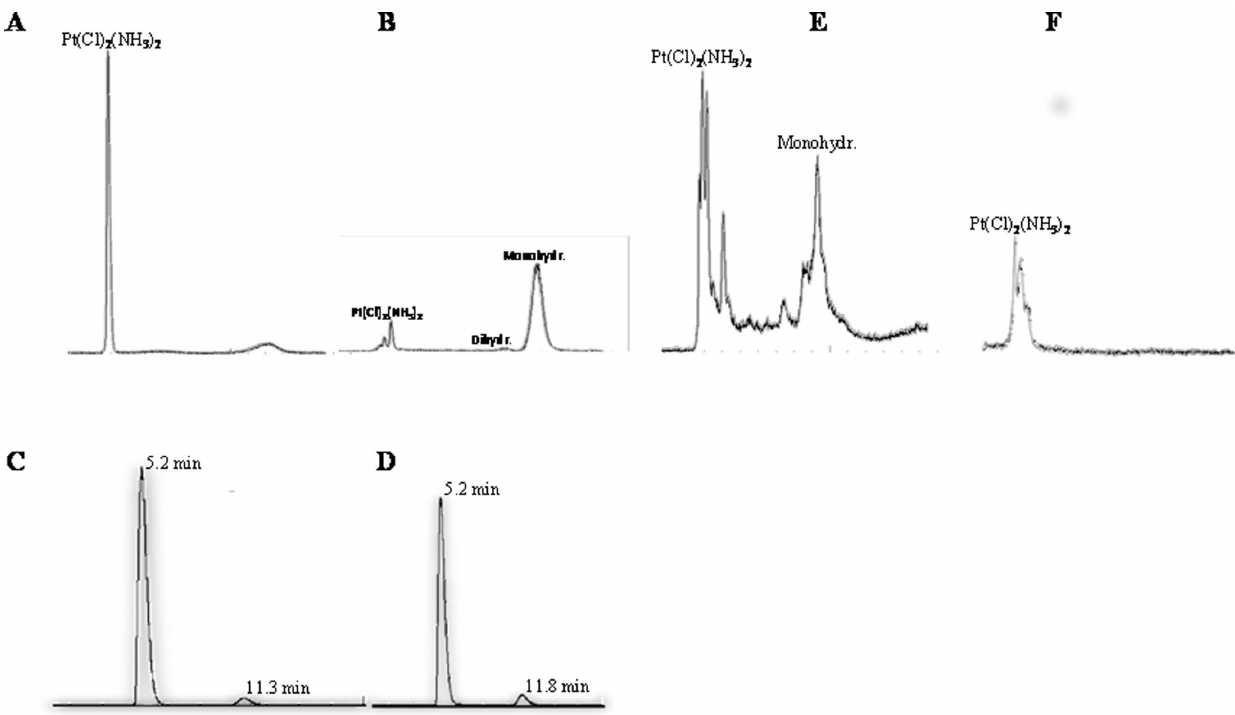
Figure 4. HPLC-Q-ICP-MS chromatograms of a standard solution of CisPt. Chromatogram of CisPt solution dissolved in NaCl 0.9% (A) and in water after sonication (30 min) at 80 u C (90 min) (B). Chromatograms of CisPt dissolved in cell culture medium after dissolution (C) and after 6 hours incubation (D), peak of native form of Cis-Pt at 5.2 min; peak of monohydrated CisPt at 11.3 min. Chromatogram of Me30966 cells lysate solution containing native and monohydrated forms of CisPt (E); chromatogram of exosomes lysate solution containing only the native form of the drug (F). Representative of three independent experiments are reported.